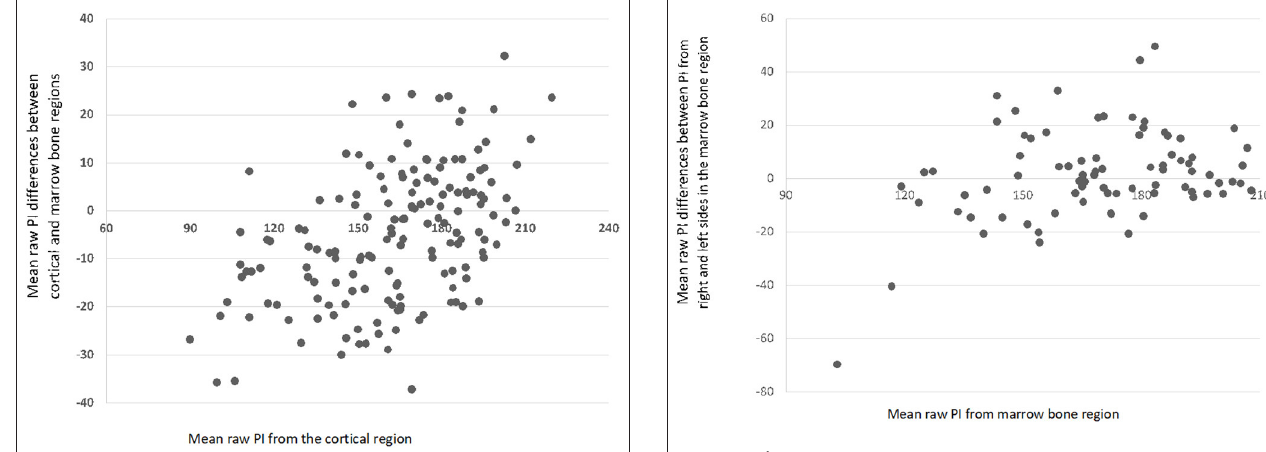
( Table 2 ). The association between subtrochlear UTN of raw and normalized pixel intensity ROIs 1, 2, and 3 was also statistically significant ( P < 0.05)